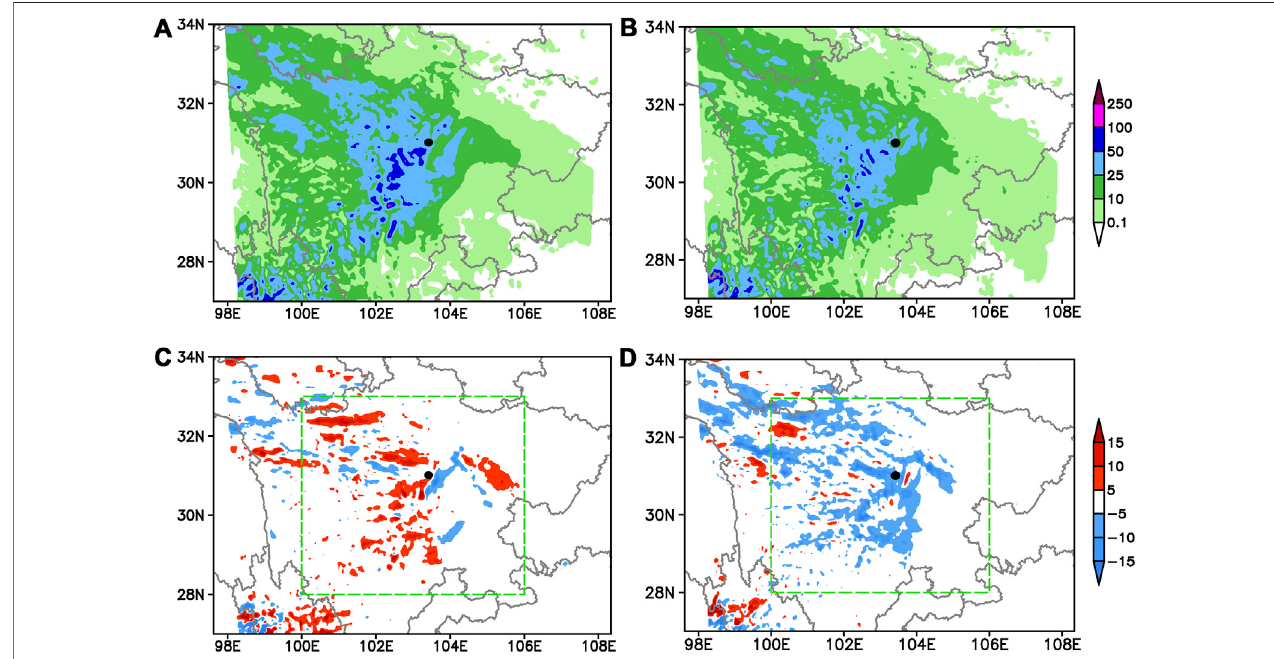
FIGURE 10 | The 48-h accumulated precipitation (units: mm) from 00:00 UTC on May 12 to 00:00 UTC on May 14, 2008 for (A) the TMP+1.5 experiment, (B) the TMP − 1.5experiment, (C) thedifferencebetweentheCTLandTMP+1.5experimentsand (D) thedifferencebetweentheCTLandTMP − 1.5experiments.Theblackdots represent the epicenter of the earthquake and the green dashed rectangle represents the area near the epicenter.